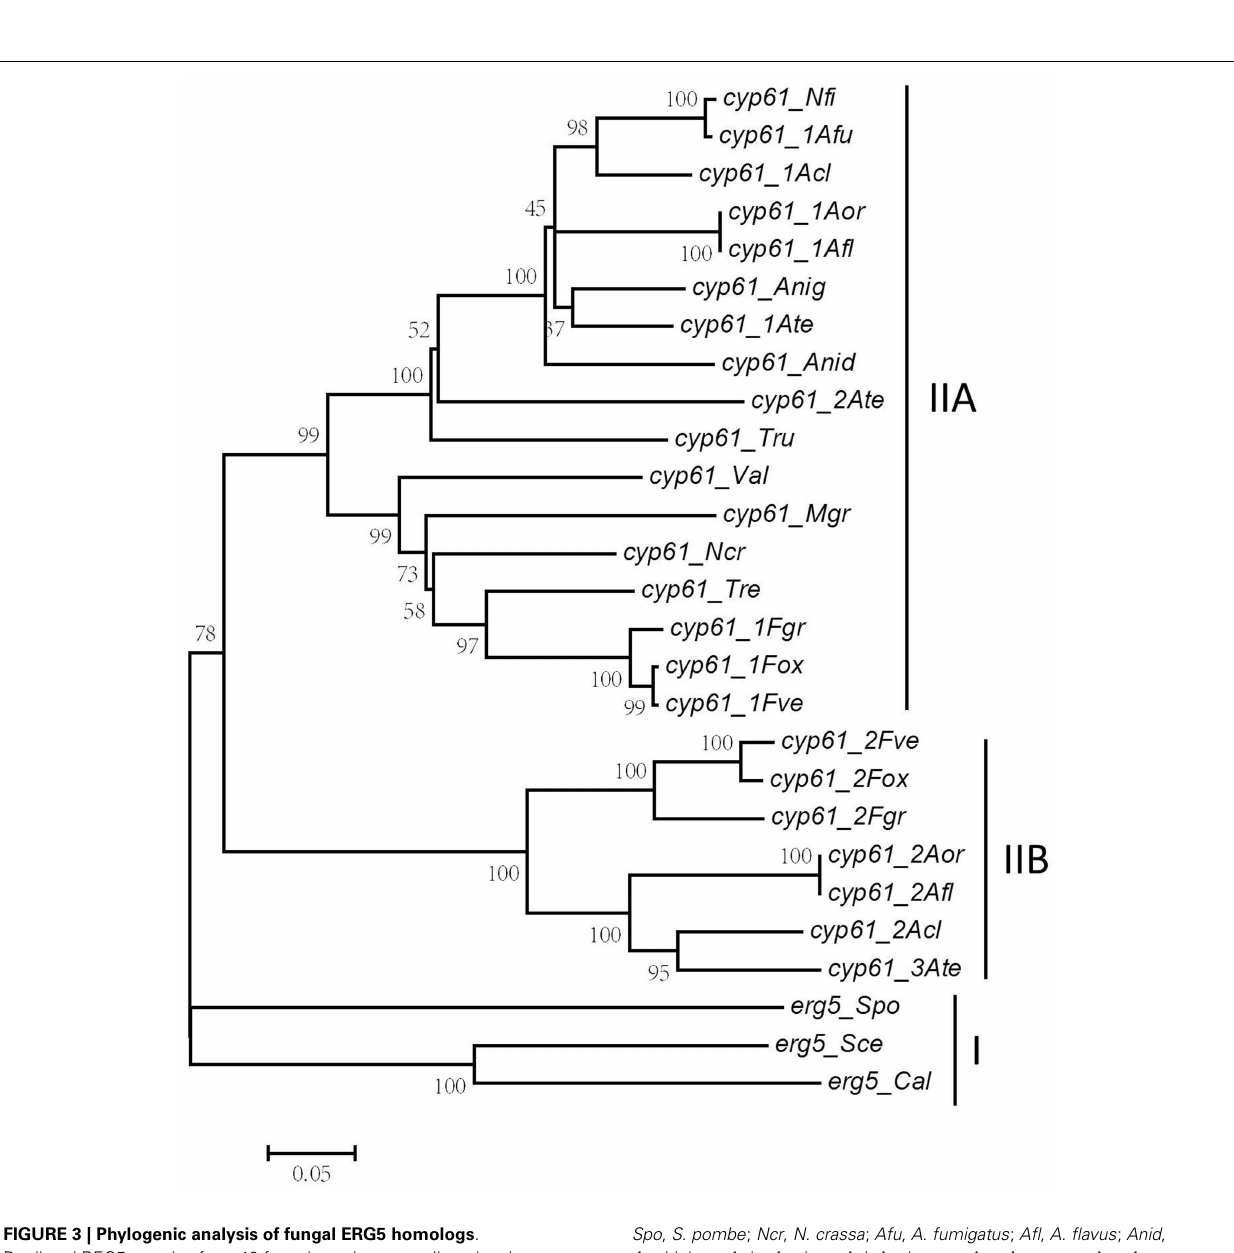
FIGURE 3 | Phylogenic analysis of fungal ERG5 homologs . Predicted REG5 proteins from 19 fungal species were aligned and a condensed neighbor-joining (NJ) tree was constructed with cut-off bootstrap values of 50% obtained from 1000 replicates using MEGA 5 software (Tamura et al., 2011). ( Cal , C. albicans ; Sce , S. cerevisiae ;